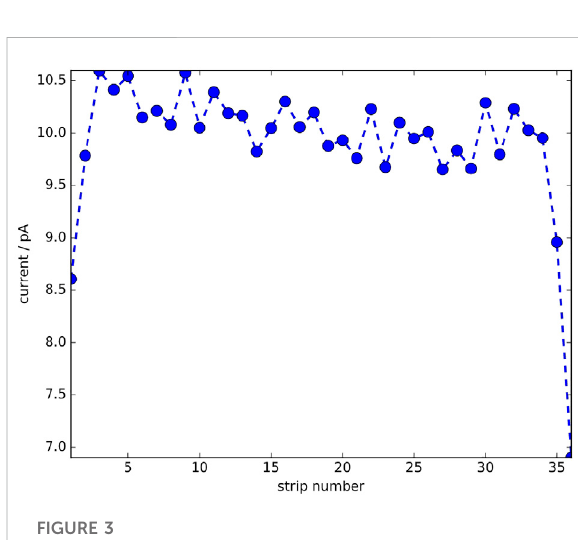
FIGURE 3 Example ofthecharacterizationofall single stripsofasensor. The plot shows the current measured on each strip at a fi xed bias voltage of the entrance window (160 V). The sensor has 32 DC- coupled strips, a strip pitch of 200 μ m and a strip length of 6 mm.